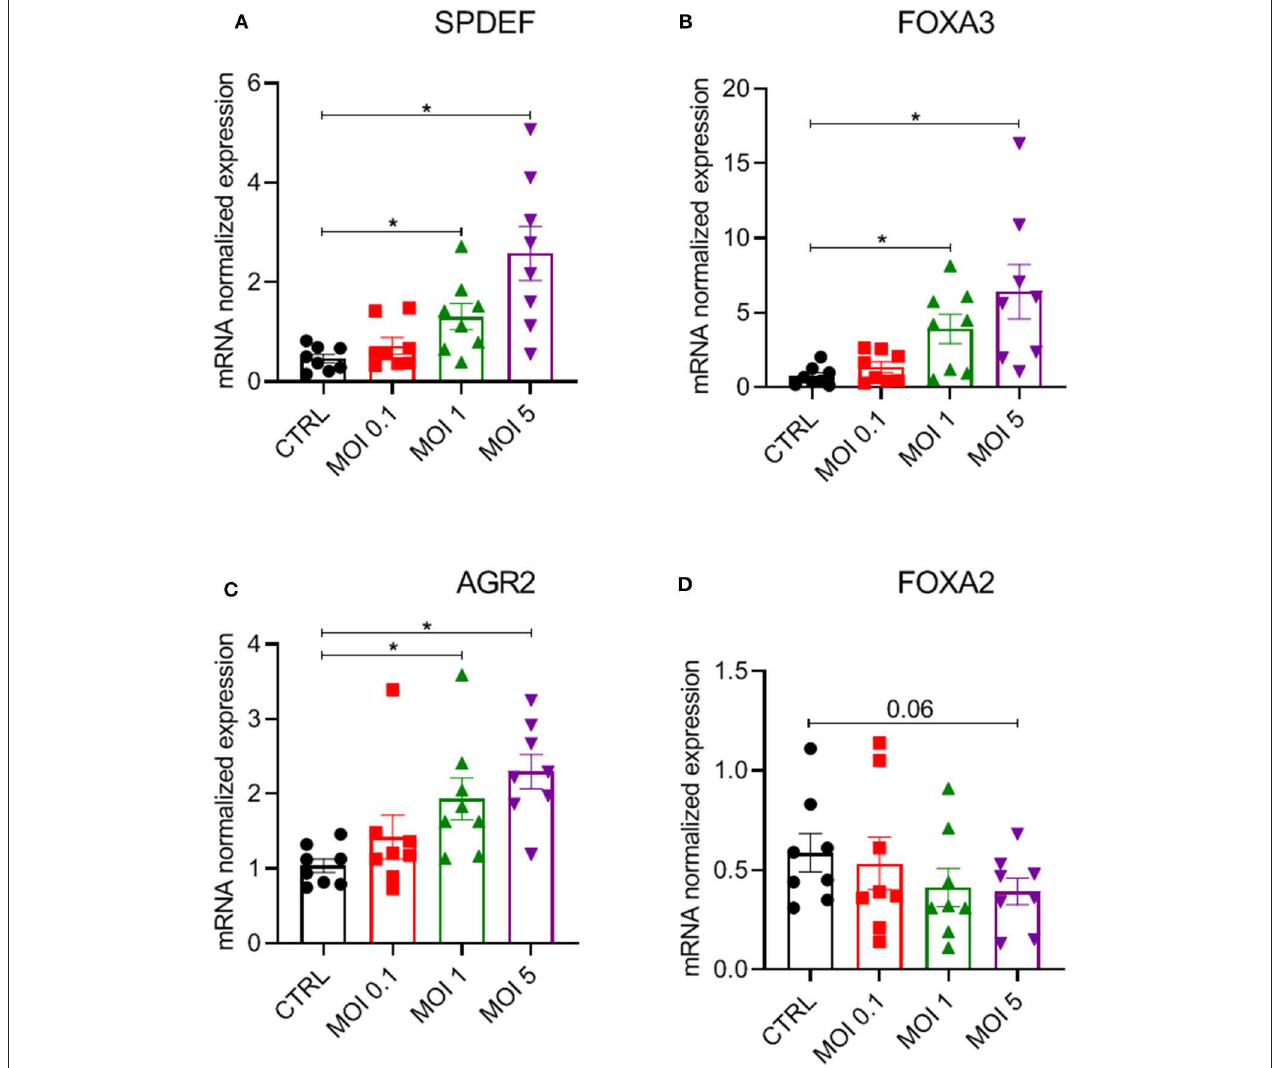
FIGURE 3 | Modulation of a network of genes relating to SPDEF by HRV-A16. ALI-PBEC were infected with HRV-A16 (MOI 0.1, 1, 5). Cells were harvested at 48h after infection. (A–D) The gene expressions of SPDEF, FOXA3, AGR, and FOXA2 were measured by real-time PCR Data are shown as target gene expression normalized for RPL13A and ATP5B. Data are mean values ± SEM. n = 8 independent donors. Analysis of differences was conducted by paired one-way ANOVA with a Tukey post-hoc test. Significant differences are indicated by * P < 0.05 compared with